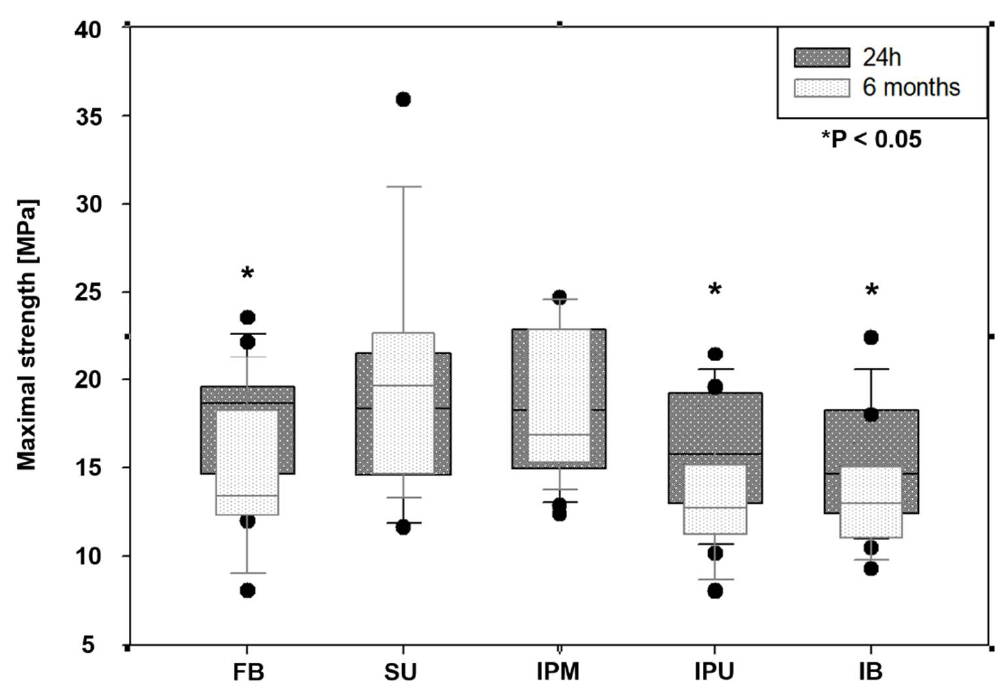
Figure 1. Evolution of the bond strength for the different universal adhesives at 24 h and 6 months. (* p < 0.05). FuturaBond M+—“FB”, Scotchbond Universal—“SU”, Iperbond Max—“IPM”, Iperbond Ultra—“IPU”, Ibond Universal—“IB”.